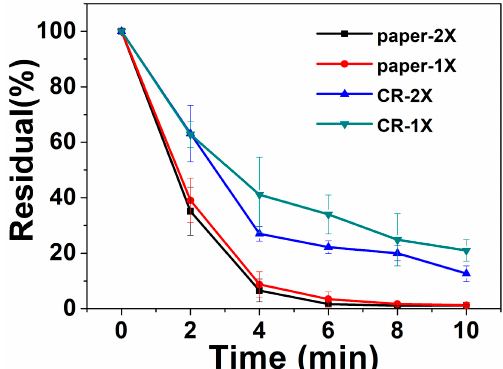
Figure 4. Comparison of the two methods with different loading amounts of mpg-C 3 N 4 . Degradation results of Paper type (paper-1× and paper-2×) show better efficiency than the coffee ring method (CR-1× and CR-2×). Paper-2× shows similar results to paper-1×, and CR-2× only shows a slightly better efficiency than CR-1×, corresponding to the aggregation of photocatalysts in the coffee ring method, which is an obvious reason for the slow reaction rate.